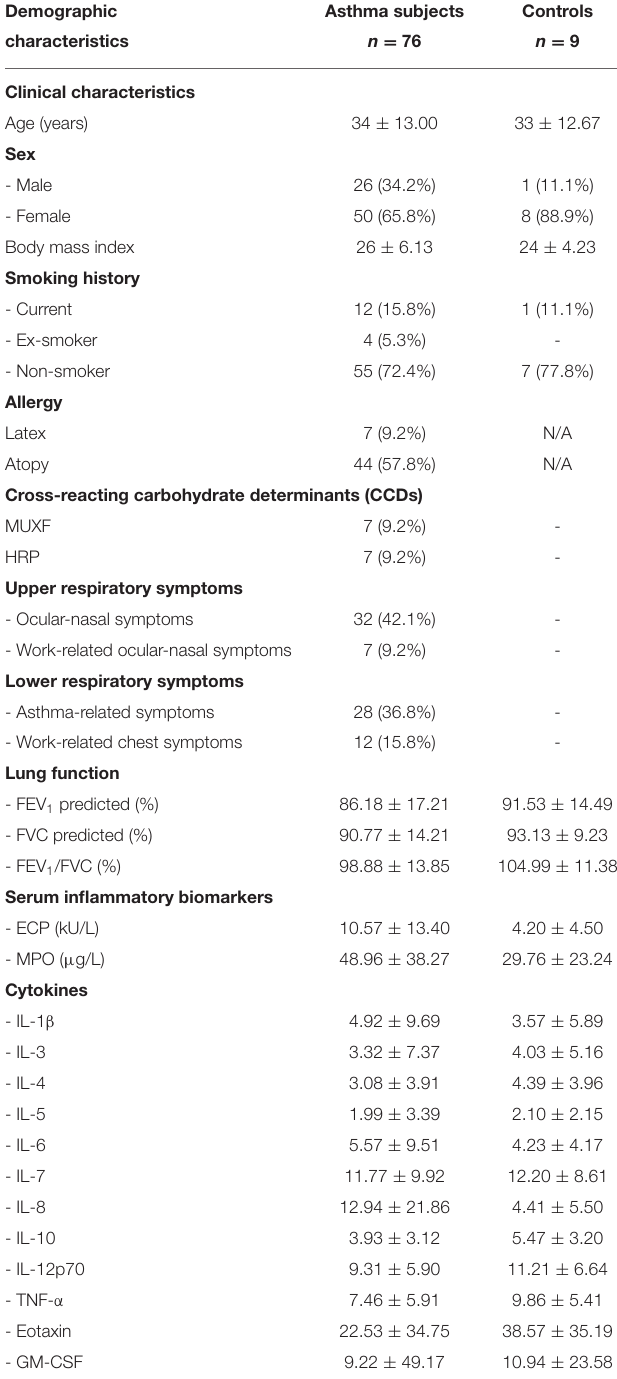
TABLE 1 | Demographic characteristics of dental healthcare